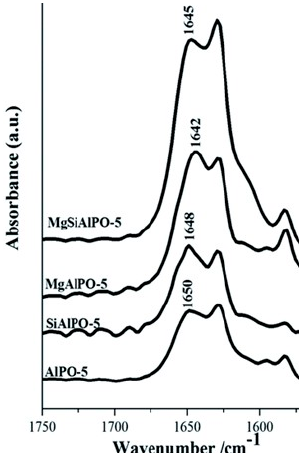
Figure 7. The FTIR spectra of 2,6-dimethylpyridine dosed on AlPO-5 and heteroatom-substituted analogues, shown at 298 K and after degassing. The relative peak position of the ν 8a mode (the labelled peak in the 1655–1640 cm − 1 range) reveals the intermediate strength of MgSiAlPO-5, since a lower wavenumber correlates with stronger Brønsted acid sites (modified from reference [49]).